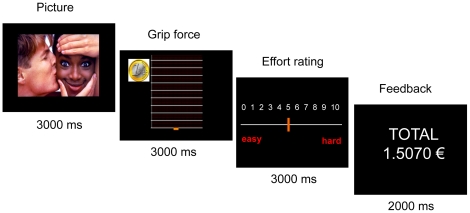
Behavioral task.Successive screenshots displayed in one trial are shown from left to right, with durations in ms. Neutral or arousing pictures (with positive or negative valence) were shown prior to physical effort exertion. Effort was cued by simultaneously showing the amount of money at stake, materialized as coin images (1 cent, 10 cents or 1 euro), and a graduated scale in which a cursor represented the force exerted on the handgrip. Subjects knew that the top of the scale corresponded to the monetary incentive, such that the more they squeezed the handgrip, the more money they would win. After force production, subjects rated the extent of their effort by positioning a cursor on an analog scale. The final screen informed subjects about the cumulative total of monetary earnings.